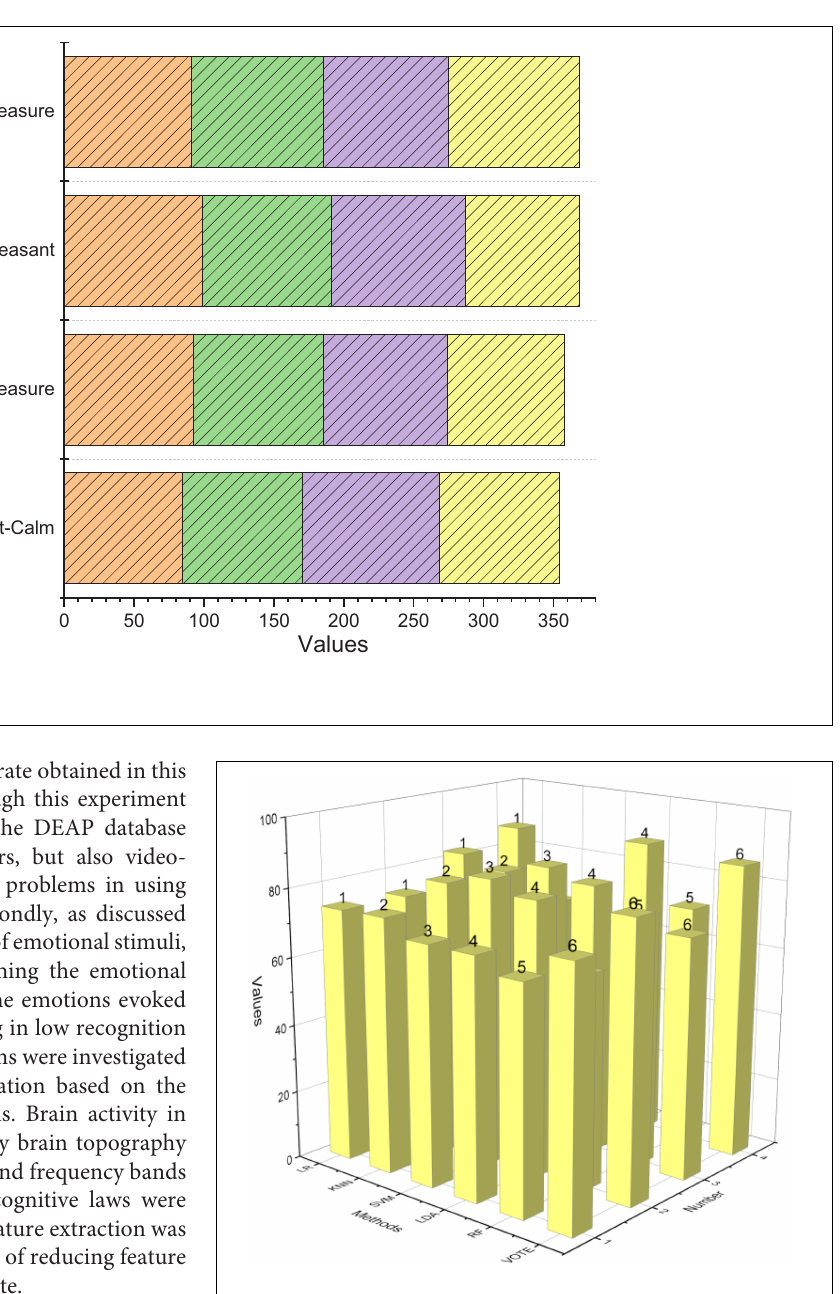
FIGURE 7 | Taxonomy